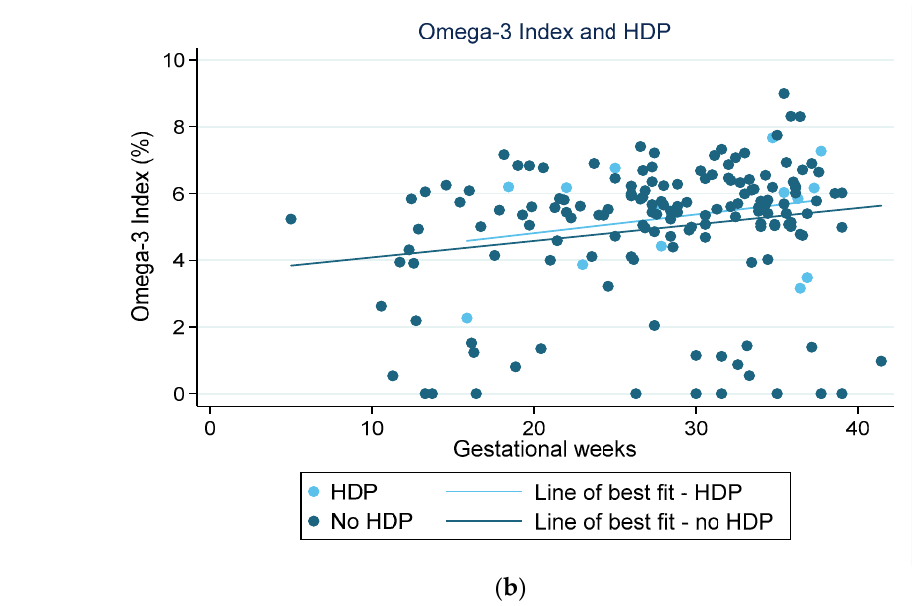
Figure 3. Omega-3 Index recorded from red blood cell membranes in pregnant women from the Gomeroi Gaaynggal cohort: ( a ) Those who experienced a preterm birth; ( b ) Those who experienced HDP (hypertension during pregnancy).